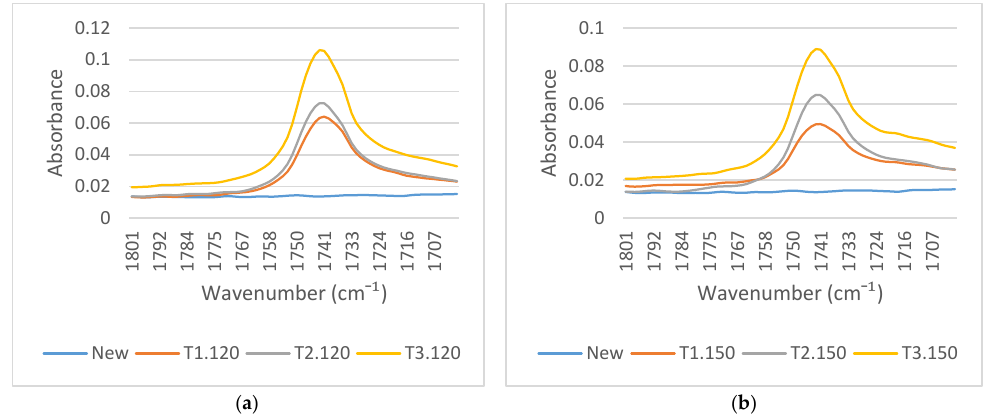
Figure 10. FTIR spectra at wavenumber 1800–1700 cm −1 of transformer insulation paper at aging temperature ( a ) 120 °C and ( b ) 150 °C.